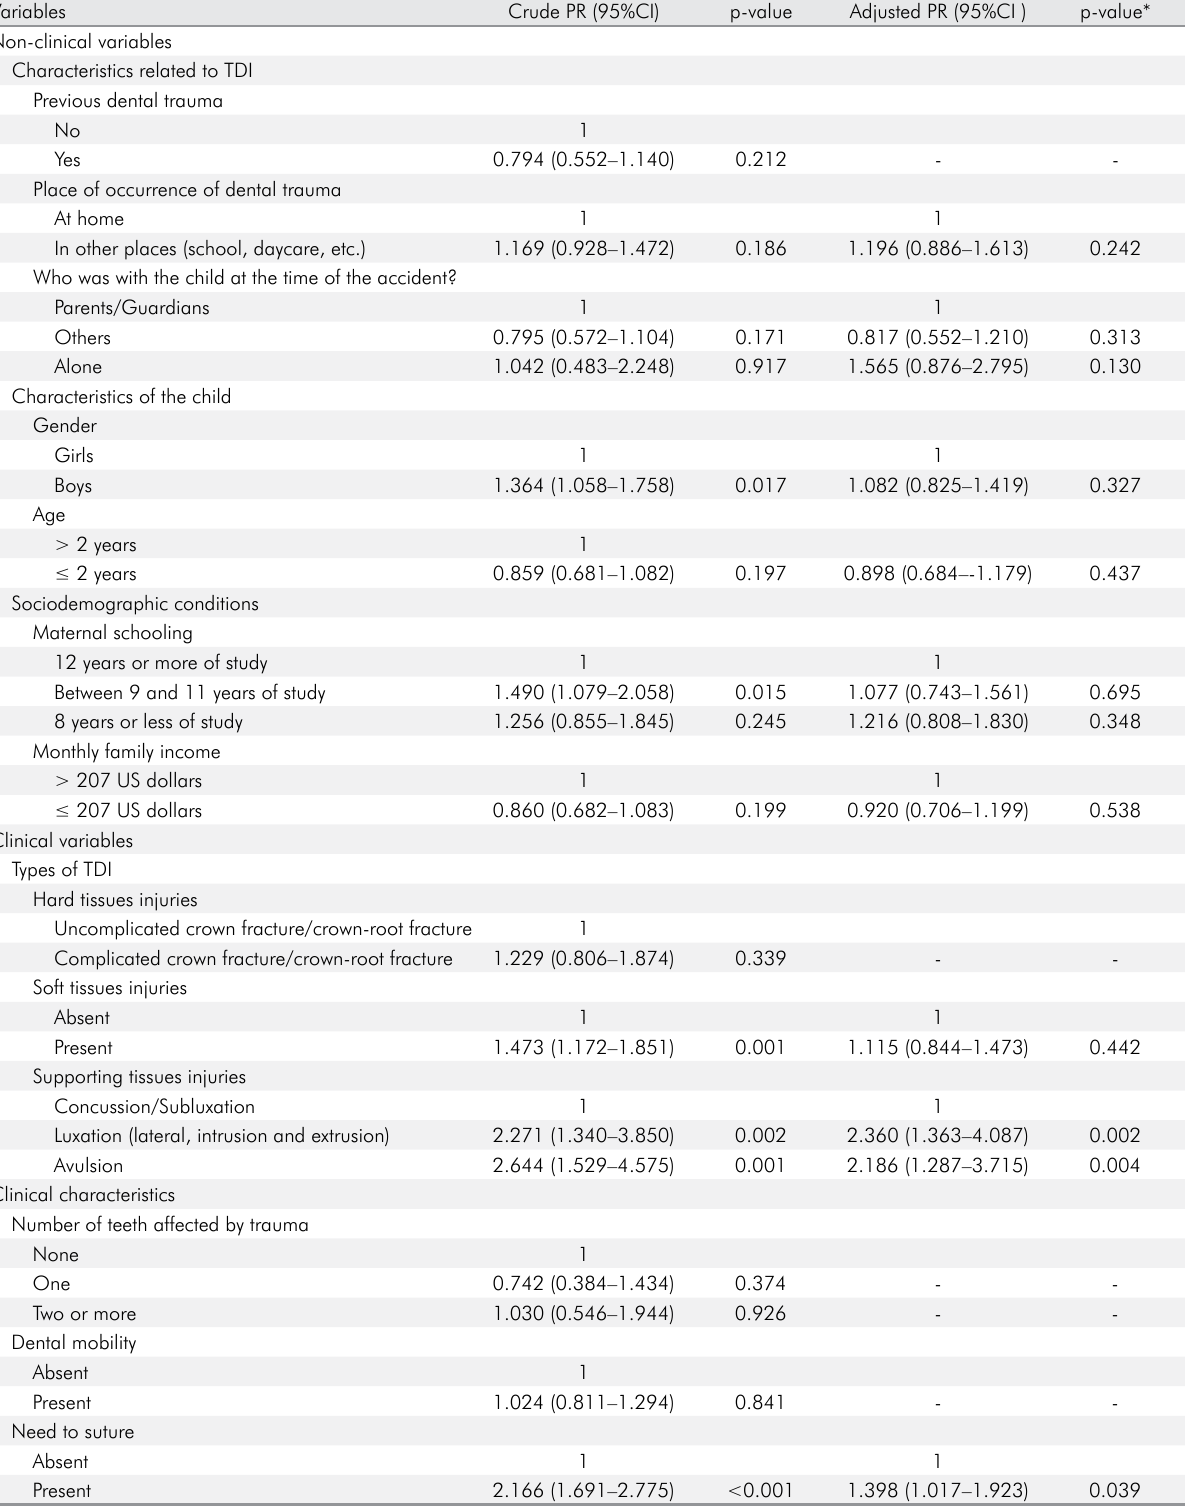
Table 2. Poisson regression model for association between immediate care seeking and the independent variables investigated in the studied children (n =